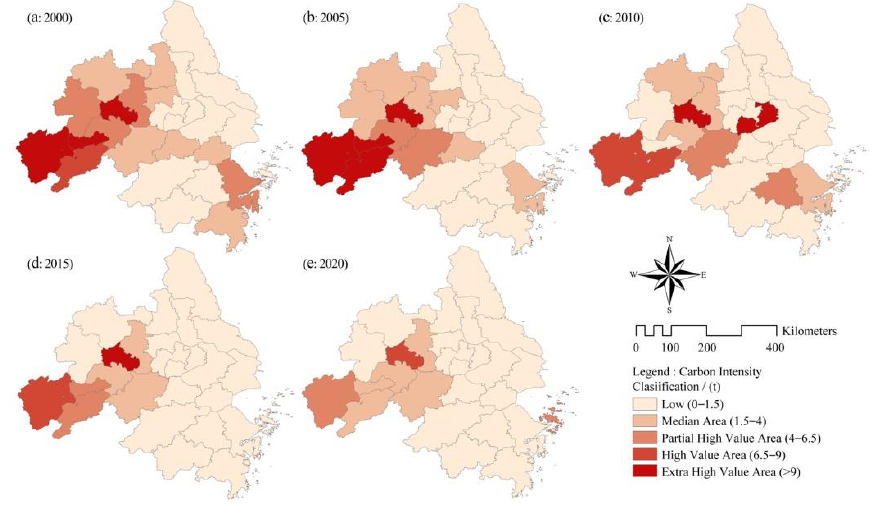
Figure 5. Spatial evolution of carbon intensity of prefecture-level cities in the YRD.